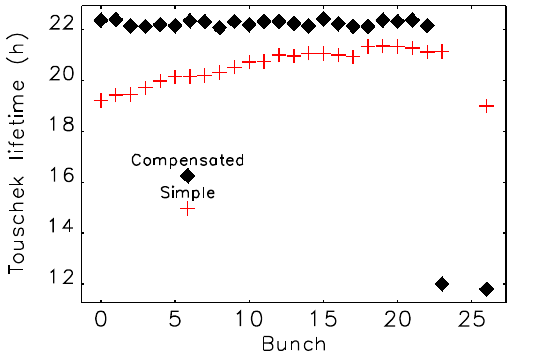
FIG. 23. Ion instability amplitude (in units of vertical beam size) for 50% NEG coating, round beams, 200 mA, 1000 Ah, and 2-bunch gaps.